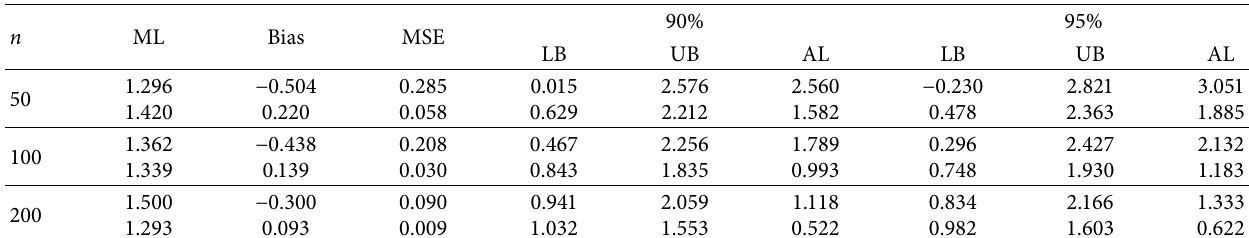
Table 4: ML estimates, biases, MSE, LB, UB, and AL of the TLIL model for α � 1.8, θ � 1.2.